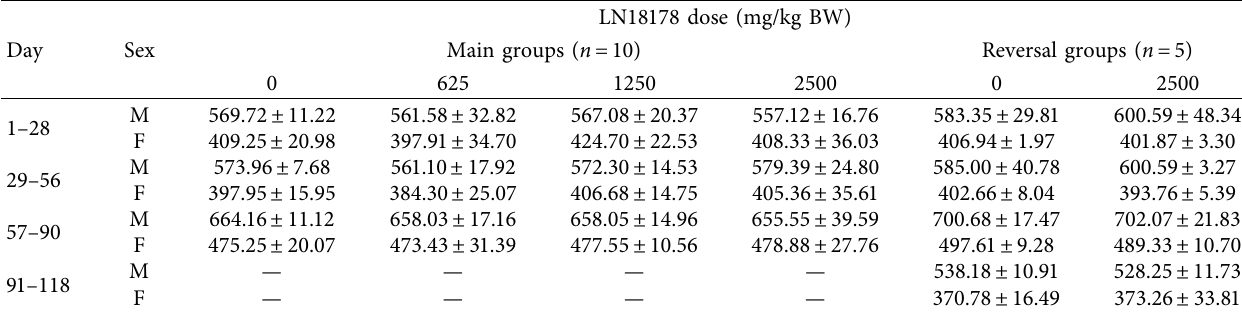
Table 2: Effect of 90-day oral administration of LN18178 on food consumption by the male and female Wistar